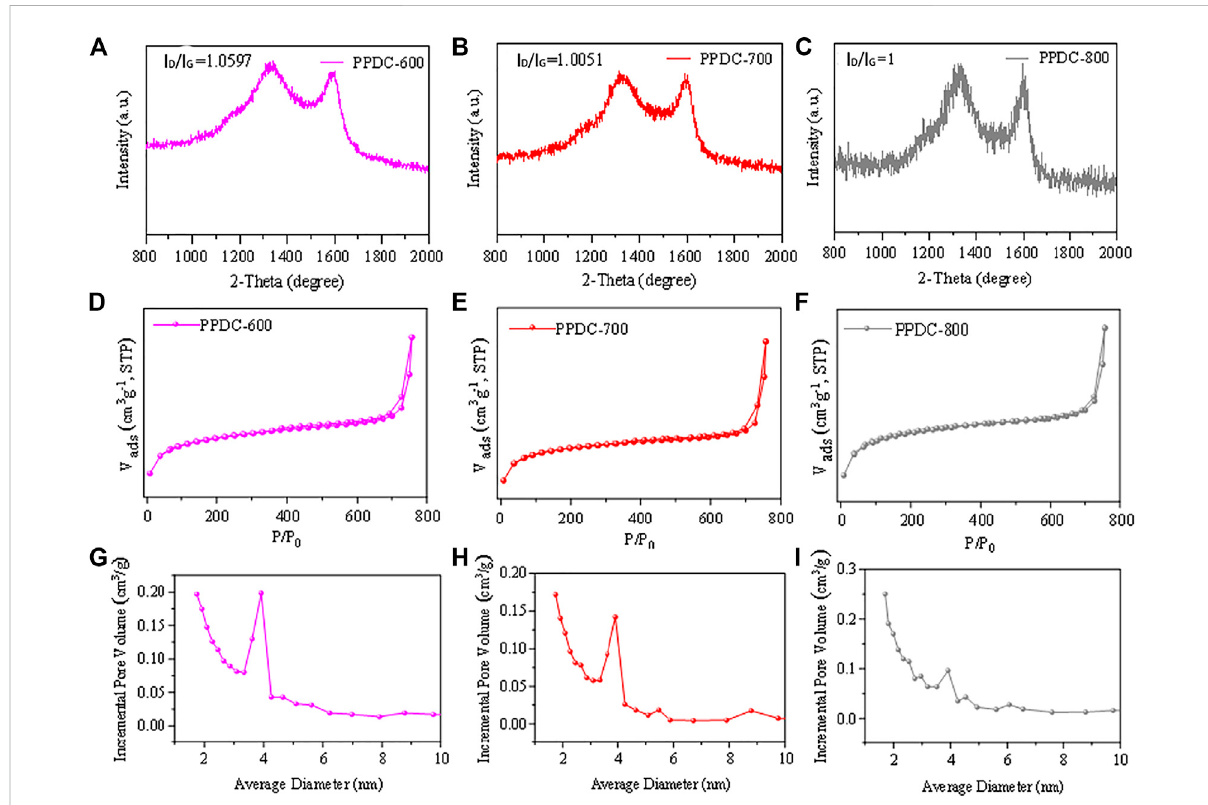
FIGURE 2 Structural and compositional information. (A,B,C) Raman spectra for PPDC-600, PPDC-700, PPDC-800, respectively; (D,E,F) N 2 adsorption- desorption isotherms for PPDC-600, PPDC-700, PPDC-800, respectively; (G,H,I) the corresponding pore size